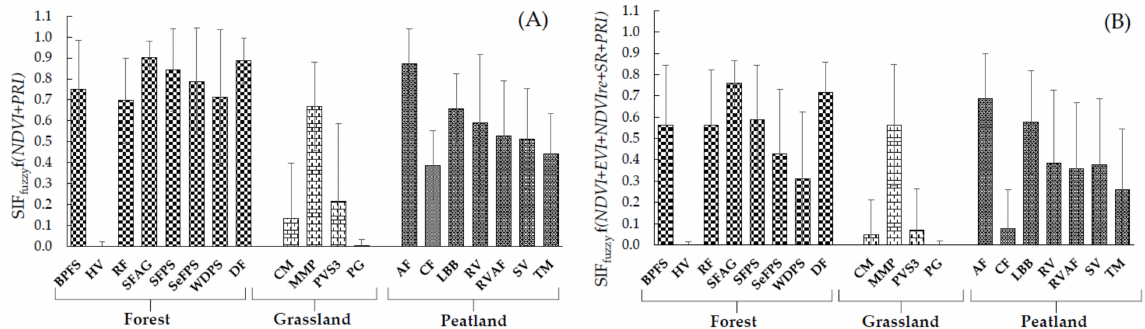
Figure 8. Example of bar diagrams representing the modelled values of SIF fuzzy obtained from 19 ROIs; ( A ) SIF fuzzy as expressed by f (NDVI+PRI) under C3; ( B ) SIF fuzzy as expressed by f (NDVI+EVI+NDVIre+SR+PRI) under C6. Error bars represent the standard